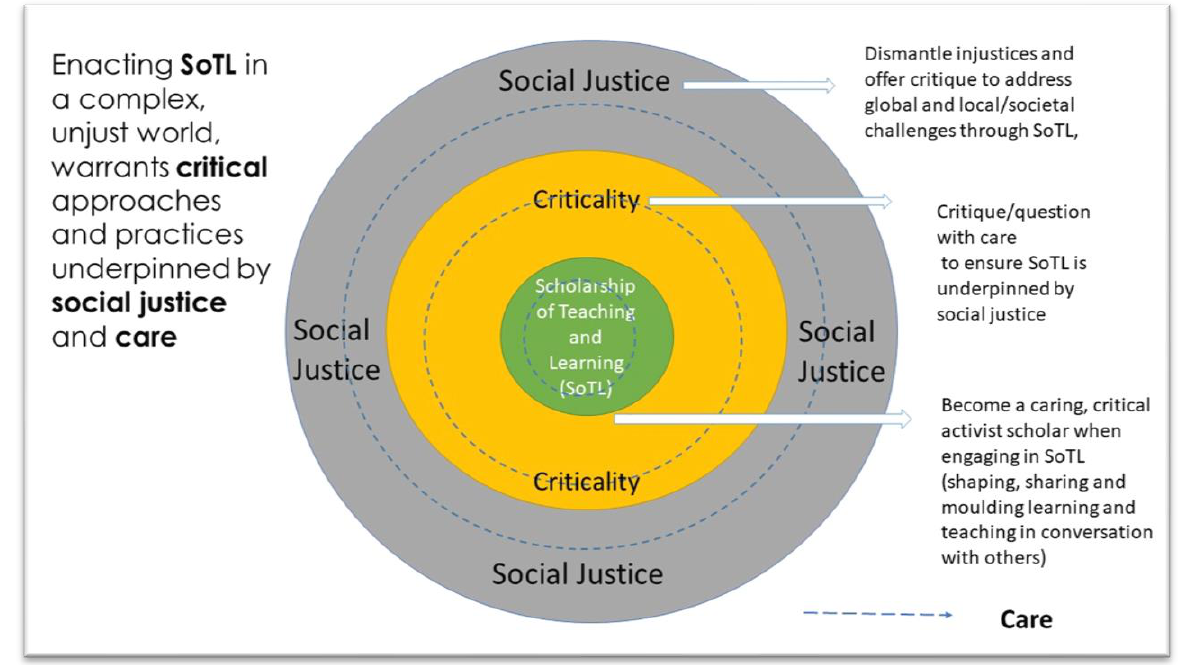
Figure 1 . SoTL underpinned by social justice, criticality and